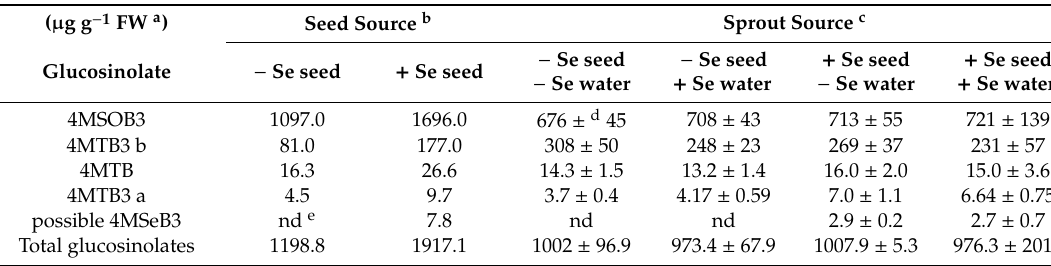
Table 2. Mean glucosinolate content in Raphanus sativus cv. ‘Rambo’ seed sourced from control and selenium (Se)-fertilised plants, and in 5-day-old sprouts produced from the same seed, following germination in the presence or absence of Se. Glucosinolates are listed in order of most to least abundant, with the Se-containing glucosinolate reported last.